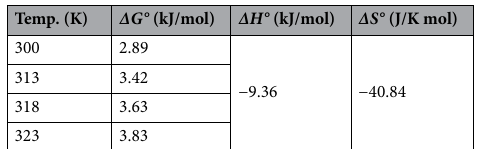
Table 5. Thermodynamic constants for the DB86 dye absorption at various temperatures on CAH.